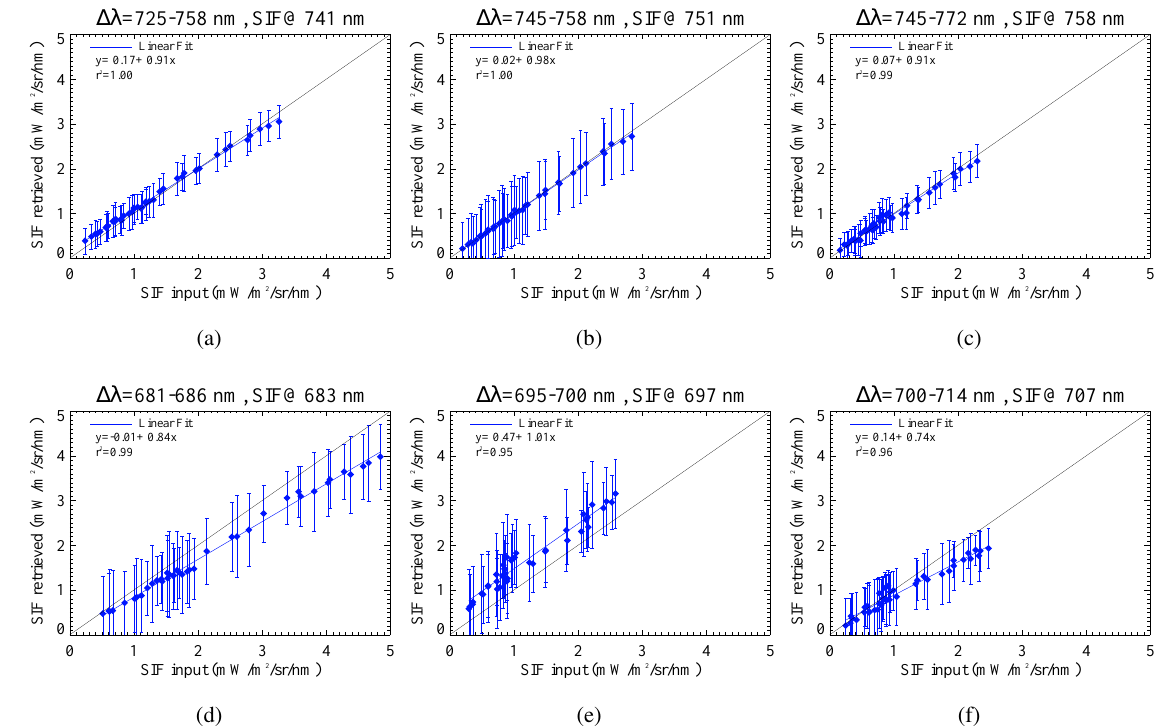
Figure 8. Similar to Fig. 6, but for different spectral fitting windows sampling the two peaks of the SIF emission. Simulations include instrumental noise. All the plots have the same axes.